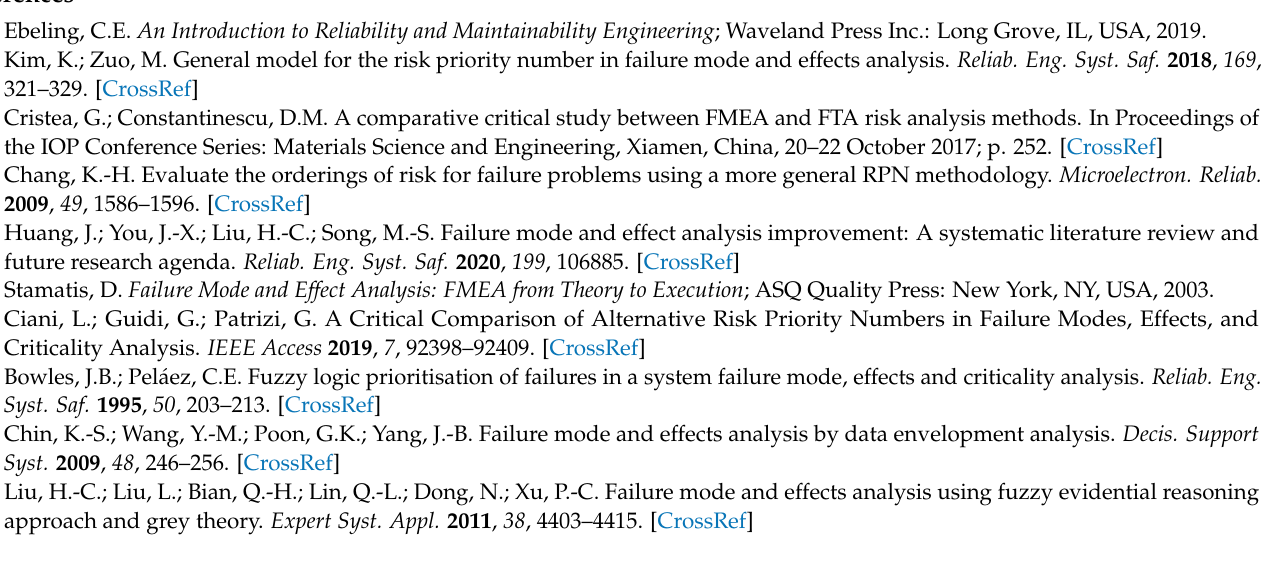
Table S3: BWM; Table S4: